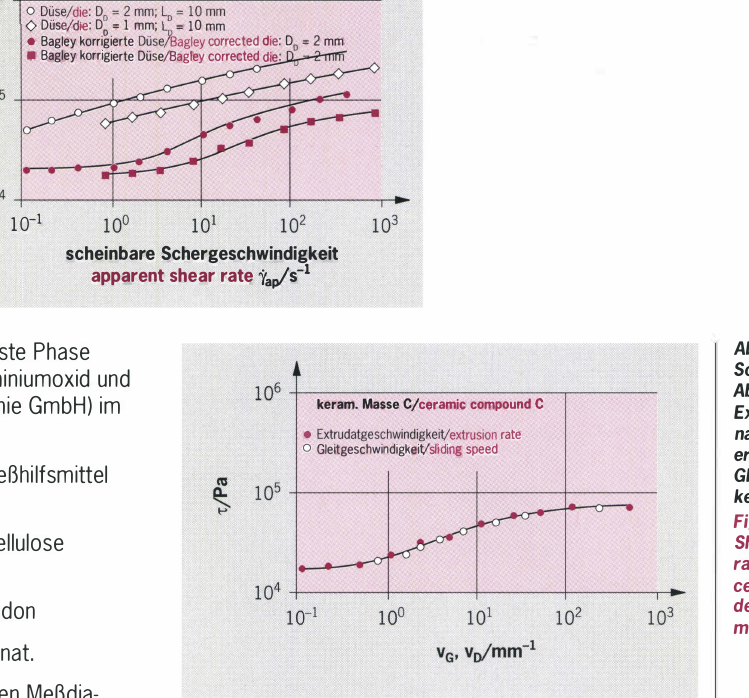
Fig.lO: Shear stress vs. extrusion rate and sliding speed for ceramic compound C, determined by the Mooney